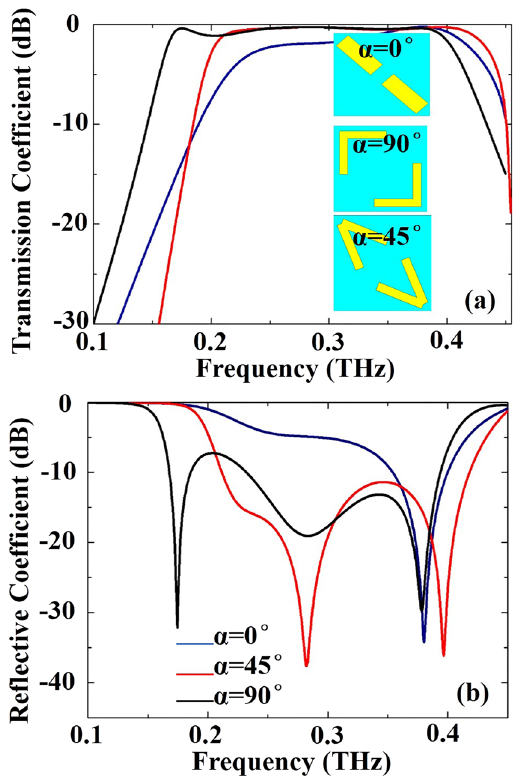
Figure 4. Simulated transmission ( t xy ) and reflection ( r xx ) coefficients for different α . The insets show the front view of the center metasurface layer for different α